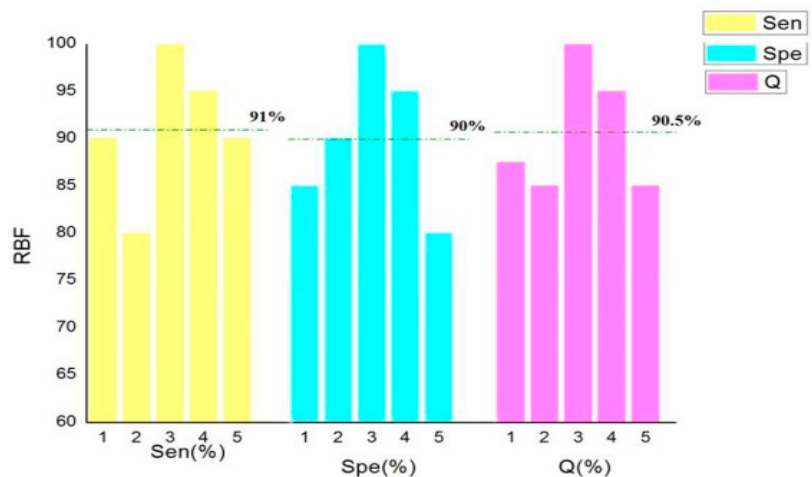
Figure 4. Cross-validation results of radial basis kernel function.